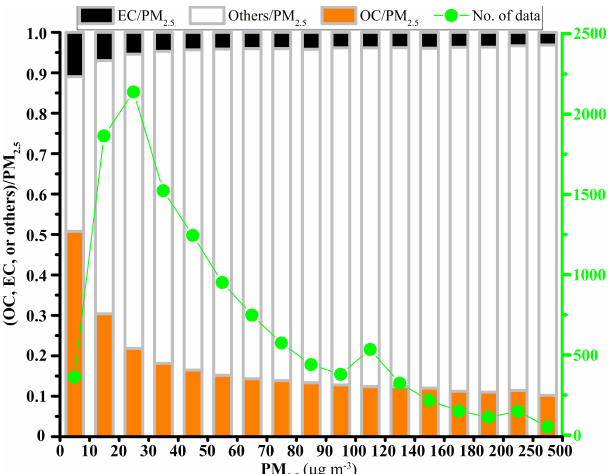
Figure 3. The contribution fraction of OC, EC, and other aerosol species to ambient PM 2 . 5 at different PM 2 . 5 concentration intervals in Shanghai between January 2013 and December